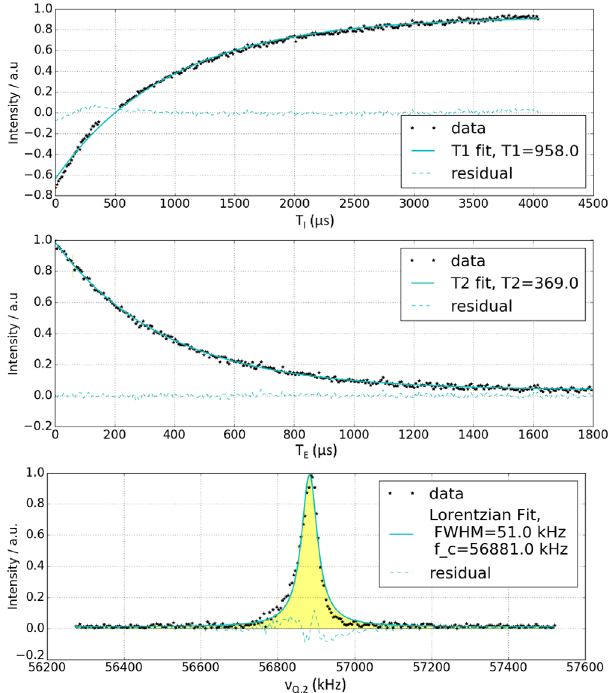
FIG. 9. Example for T 1 and T 2 measurement and fitted models; sample (4), transition 2 at 310 K. For results, see Table IV.